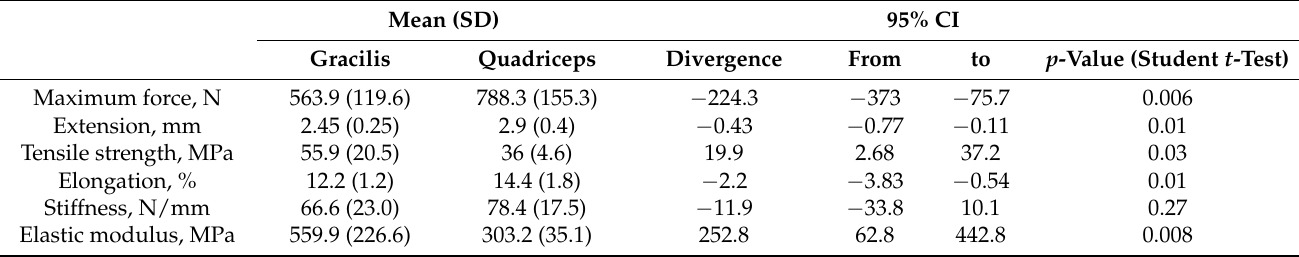
Table 4. Biomechanical properties of human gracilis and quadriceps tendons [24] (reprinted from Wertheimer, V.; Grgi´c, I.; Zeli´c, Z.; Ivandi´c, Ž.; Koprivˇci´c, I.; Zeleni´c, M.; Karakaši´c, M. (2021)). Mean (SD) 95% CI Gracilis Quadriceps Divergence From